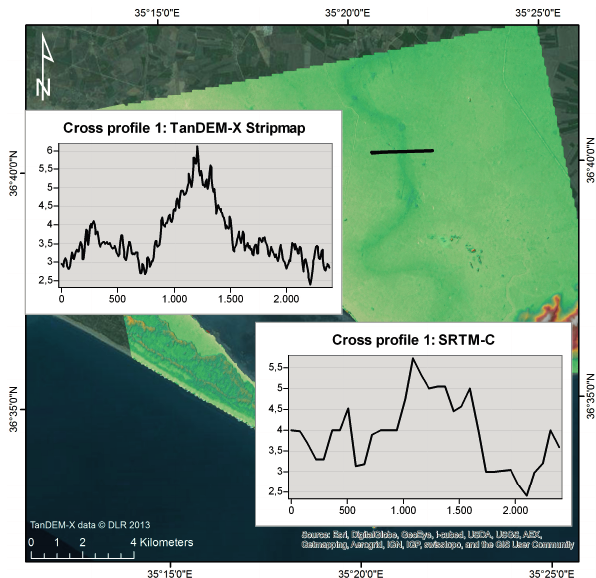
Figure 4. Cross profiles of height values extracted from TanDEM-X Stripmap and SRTM-C DEM data. The black line indicates the position of the